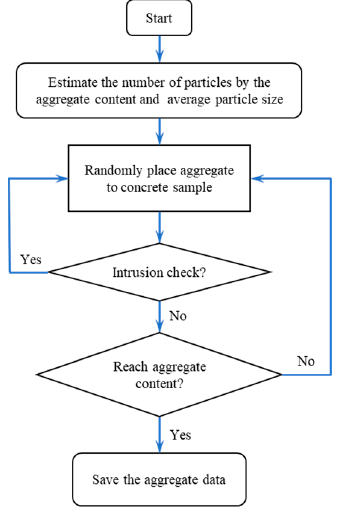
Figure 15. Three-point bending model for the finite element simulation.